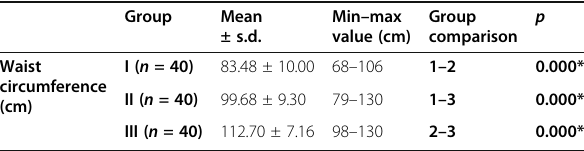
Table 6 Waist circumferences (cm) Group Mean ±